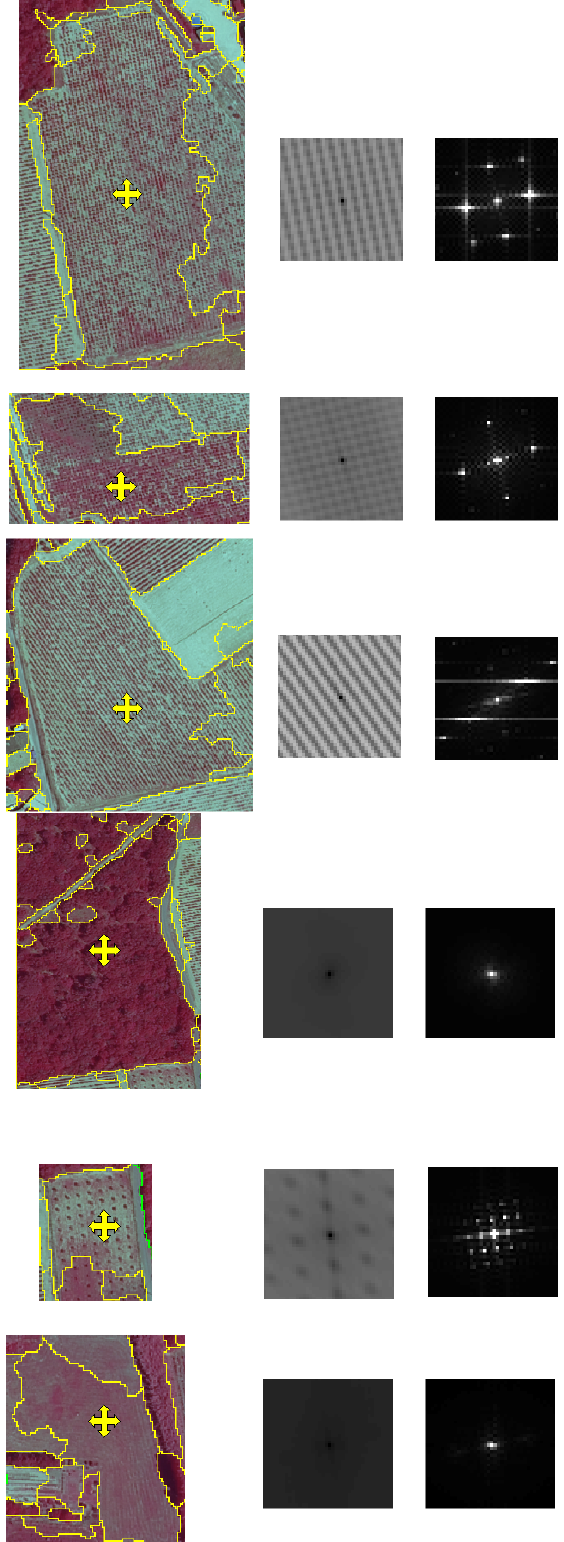
Figure 8: On each line, from left to right, segmented ortho-image, semi-variogram of the yellow crossed region, modulus of the FFT of this